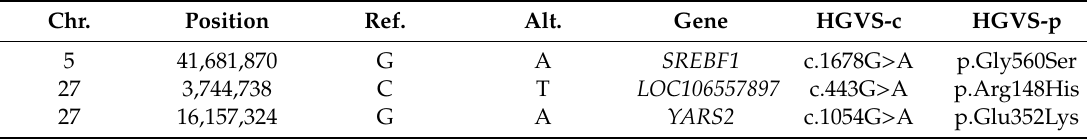
Table 2. Details of three private protein-changing candidate